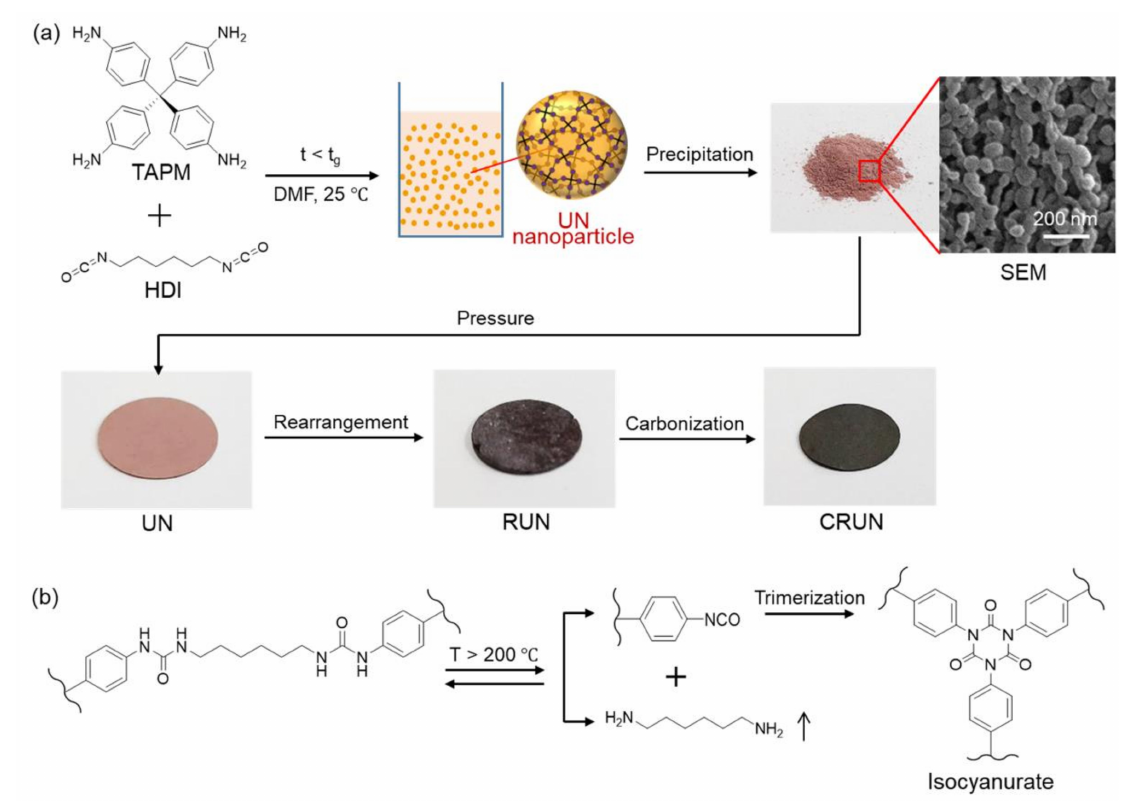
Figure 1. Schematic illustration of the preparation of the UN and its transformation into RUN and CRUN. ( a ) The polymerization of TAPM and HDI to obtain the UN in the sol state. Optical pho- tographs of the powdery UN were obtained by precipitating the UN sol into acetone, the disk-shaped UN (diameter 1.3 cm and thickness 0.5 cm), RUN (diameter 1.1 cm and thickness 0.4 cm), and CRUN (diameter 0.9 cm and thickness 0.3 cm). The SEM image shows the nanoparticulate morphology of the UN powder. ( b ) A major change in chemical structure occurs with the rearrangement of urea